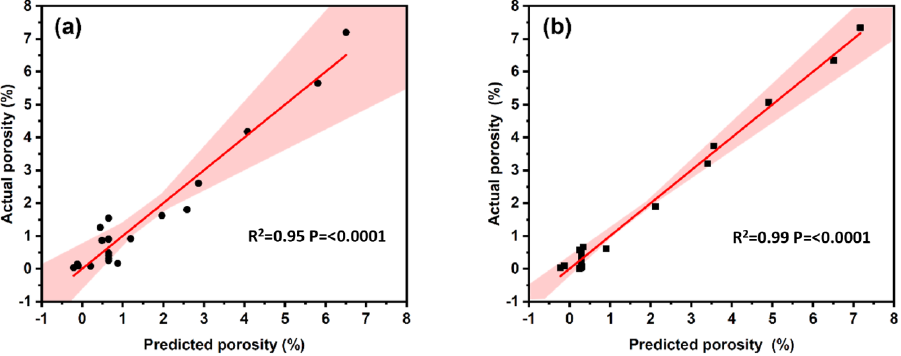
Figure 9. Porosity modeling of ( a ) optical data and ( b ) XCT